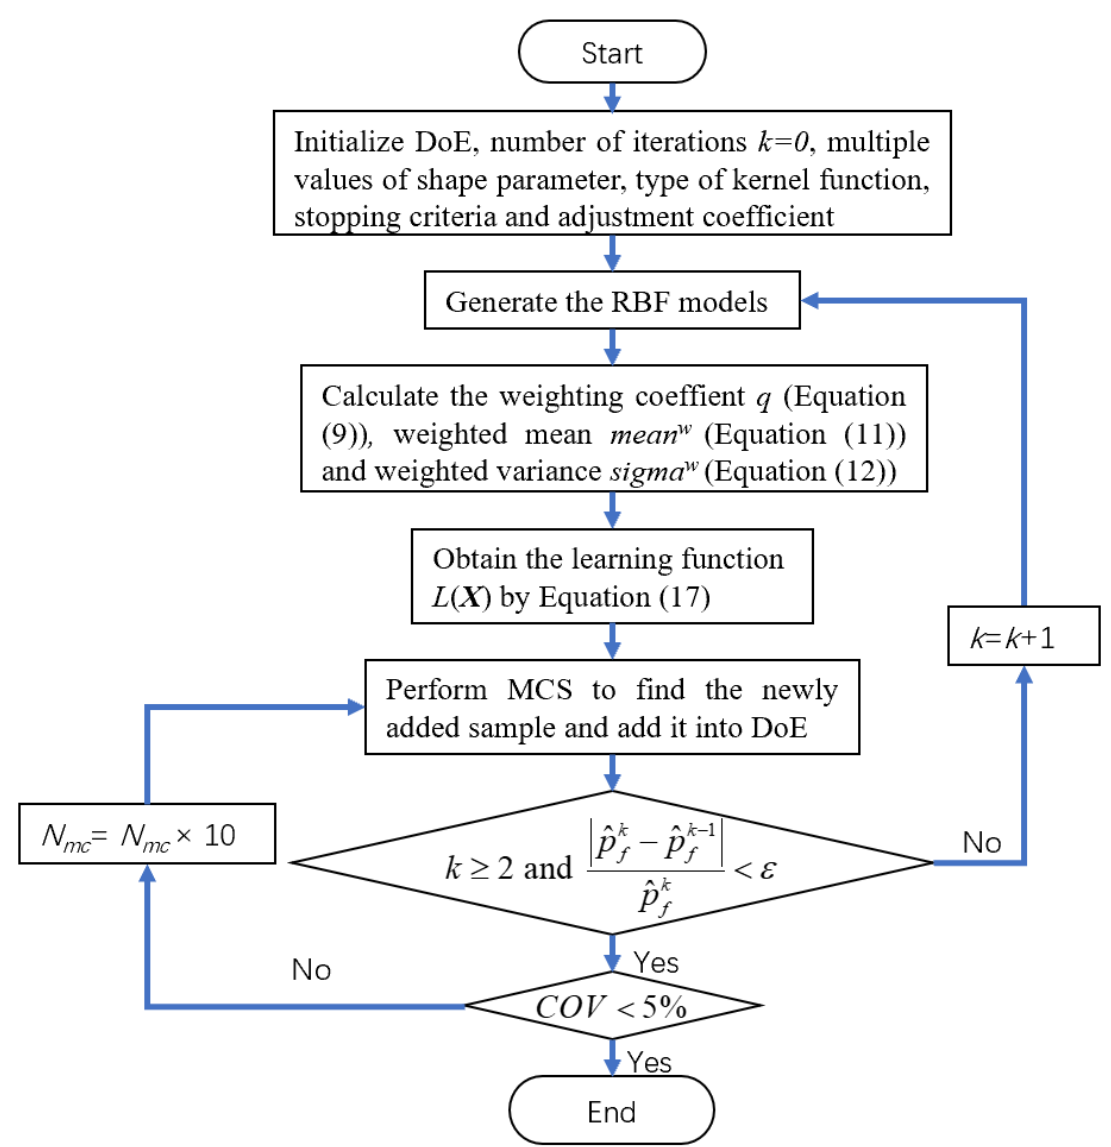
Figure 2. The flowchart of MSRBF-MCS.